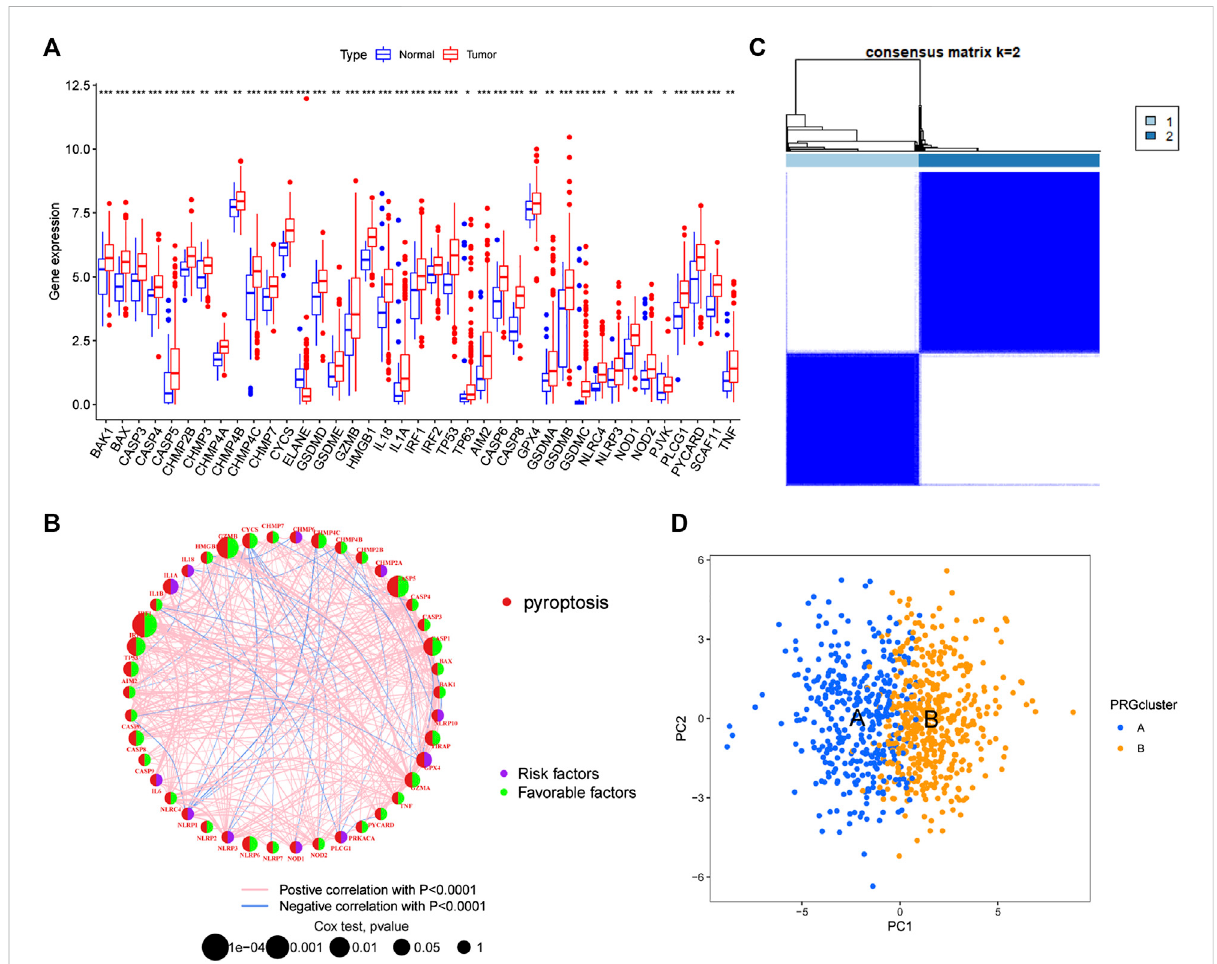
FIGURE 2 Identi fi cationofpyroptosis-related subtypes (A) Differential expression ofPRGsbetweentumourtissues andnormaltissues (B) PRGinteraction network (C) Consensusunsupervisedclusteringde fi nestwoclusters( k =2)andtheircorrelationarea (D) PCAdividedGCsamplesintotwosubtypes. PCA: principal Component